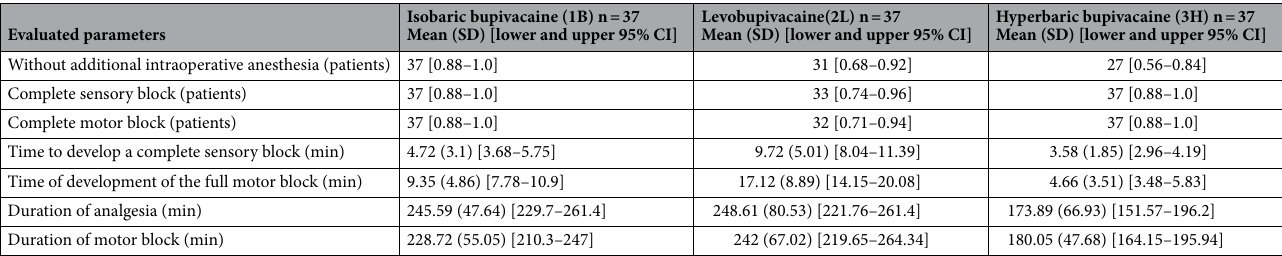
Table 3. Characteristics of spinal anesthesia in the study groups with 95% CI. CI confidence interval, SD standard deviation.